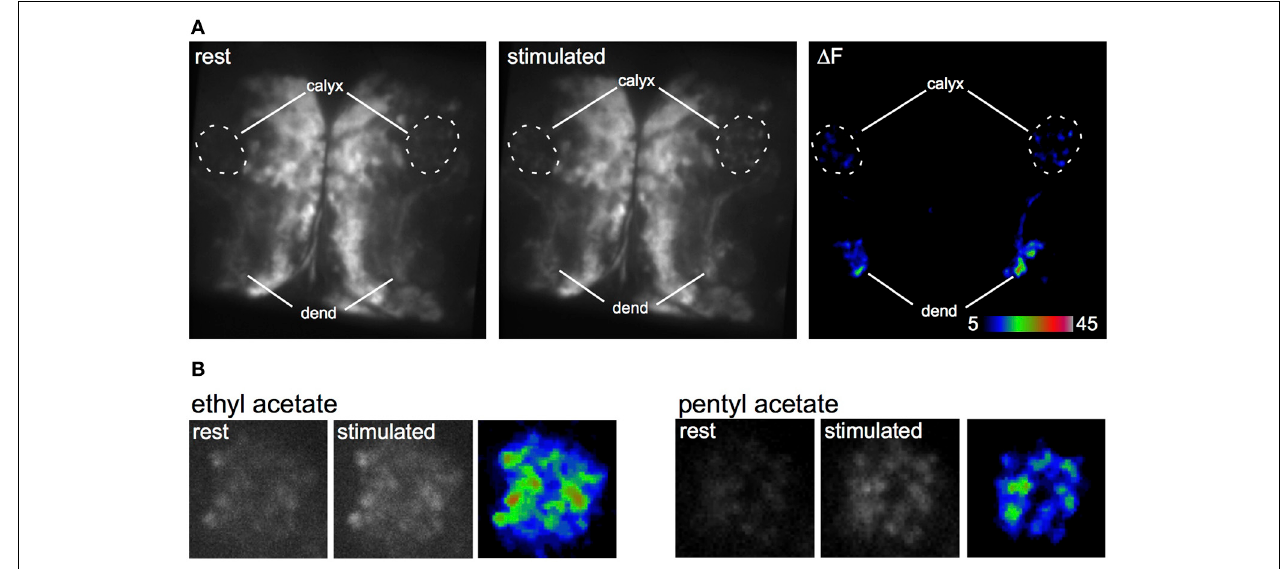
FIGURE 4 | Odor-evoked responses in the larval APL. (A) Response of two larval APLs from the same brain to a pulse of ethyl acetate, shown by increased GCaMP fluorescence in both dendrites (dend) and calyx, in a larva that expresses GCaMP3 under control of NP2631-GAL4 . (B) Response of